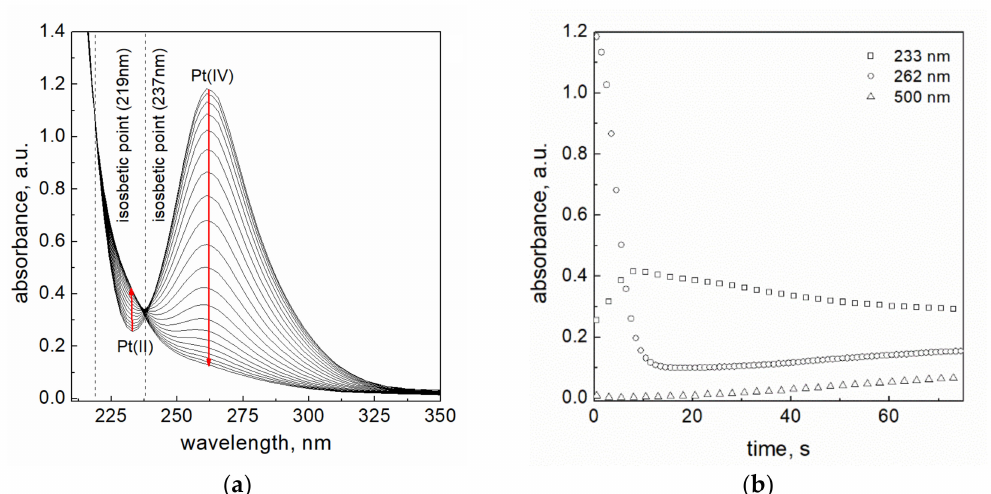
Figure 2. ( a ) Change of absorption bands characteristic for Pt(IV) complex ions during the reaction with NaBH 4 . Conditions: C 0,Pt(IV) = 0.05 mM, C 0,NaBH4 = 3.0 mM, I = 0.05 M, T = 50.0 ± 0.1 ◦ C, pH = 12.9 ± 0.2. Time of reaction 10 s (with step 0.2 s); ( b ) the change of absorbance value (A ∝ concentration of Pt species) with time (kinetic curves) during the reaction of platinum ions with NaBH 4 . Conditions: C 0,Pt(IV) = 0.05 mM, C 0,NaBH4 = 3.0 mM, I = 0.05 M, T = 50.0 ± 0.1 ◦ C, pH = 12.9 ± 0.2, path length 1